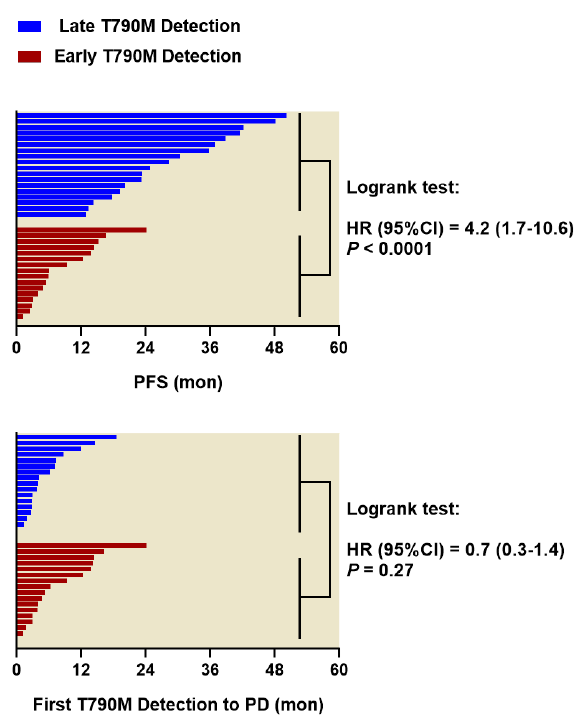
Figure 3. In patients treated by first-line EGFR-TKIs, ( A ) progression-free survival (PFS, interval between treatment initiation and disease progression) was significantly longer in the late T790M detection group (n = 18; first T790M detection: > 3 months after treatment initiation) than in the early T790M detection group (n = 16; first T790M detection: at treatment initiation ± 3 months); ( B ) however, the interval between first T790M detection and disease progression was not significantly di ff erent between the two groups. p -values were obtained by Logrank test.